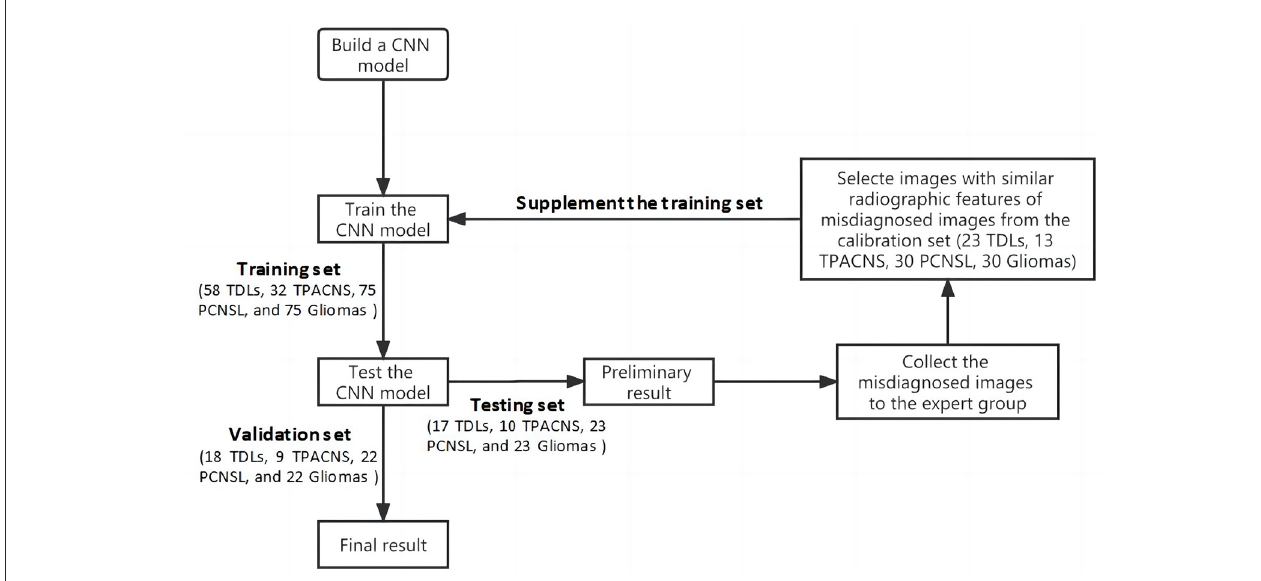
FIGURE2 Flow chart of the training of the CNN model.